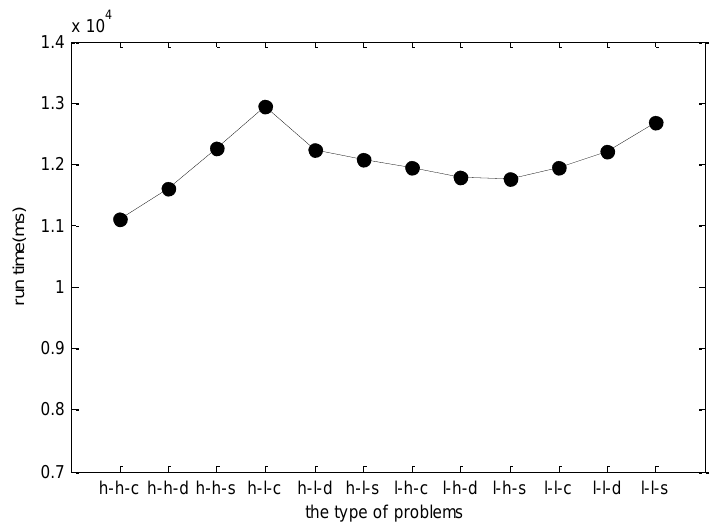
Figure 13. The DPSO-DA runtime for different types of test